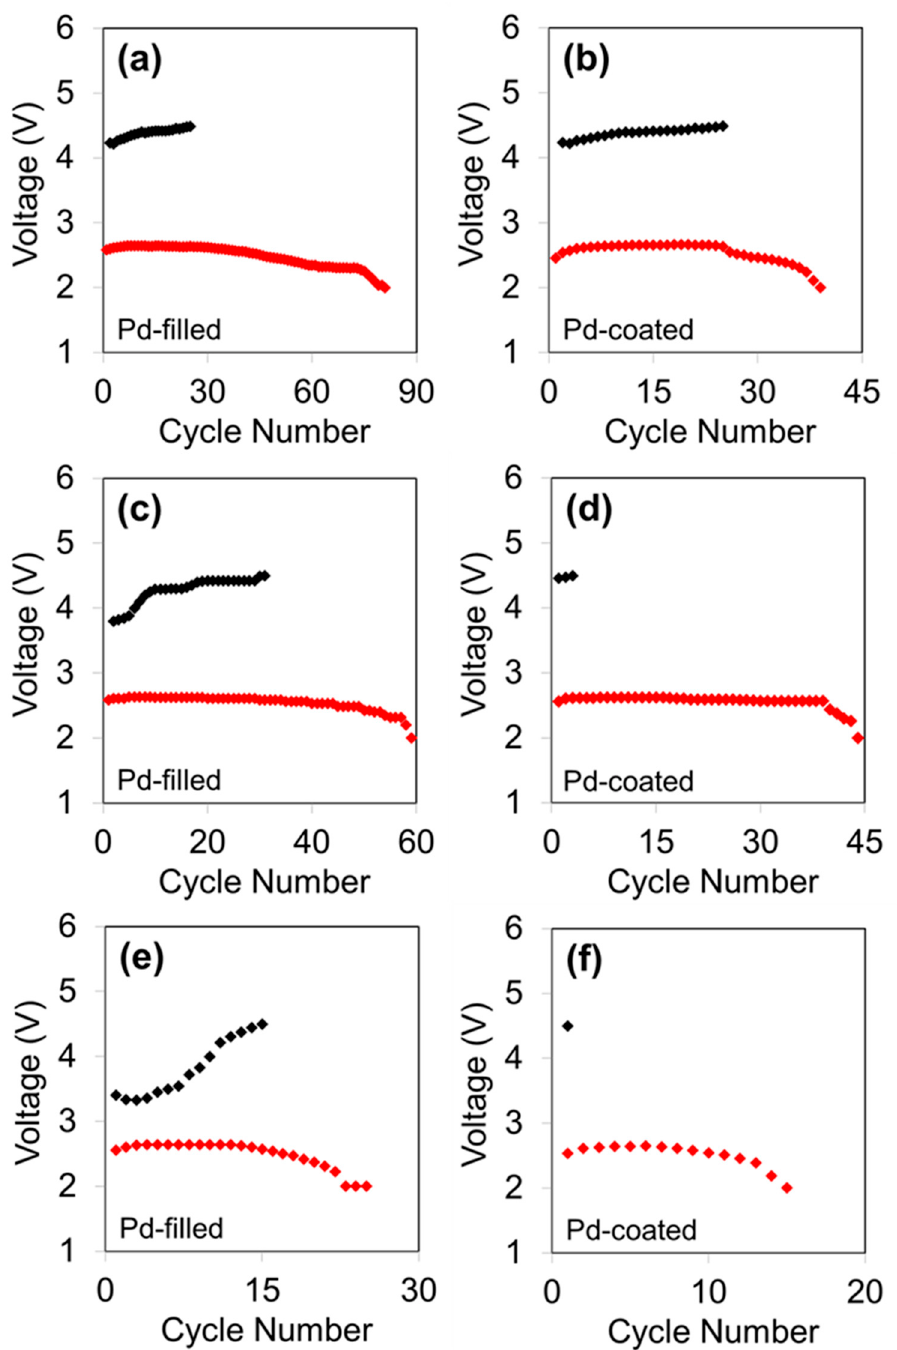
Figure 2. End charge/discharge voltages of ( a , c , e ) palladium-filled and ( b , d , f ) palladium-coated CNTs after full cycles to 250 mAh.g − 1 , 500 mAh.g − 1 , and 1000 mAh.g − 1 , respectively.